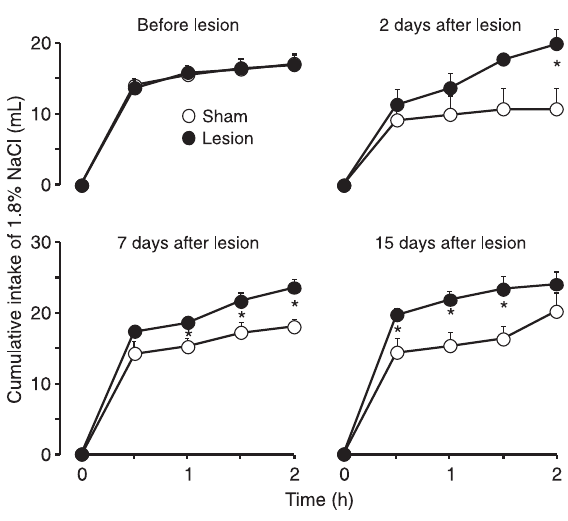
Figure 2. Cumulative intake of 1.8% NaCl by sodium-depleted rats before surgery, and 2, 7, and 15 days after commissural nucleus of the tractus solitarius lesions or sham lesions. Data are reported as means ± SEM for 6 sham and 7 lesioned rats in each group. *P < 0.05 compared to sham-lesioned rats (two-way ANOVA followed by the Tukey post hoc